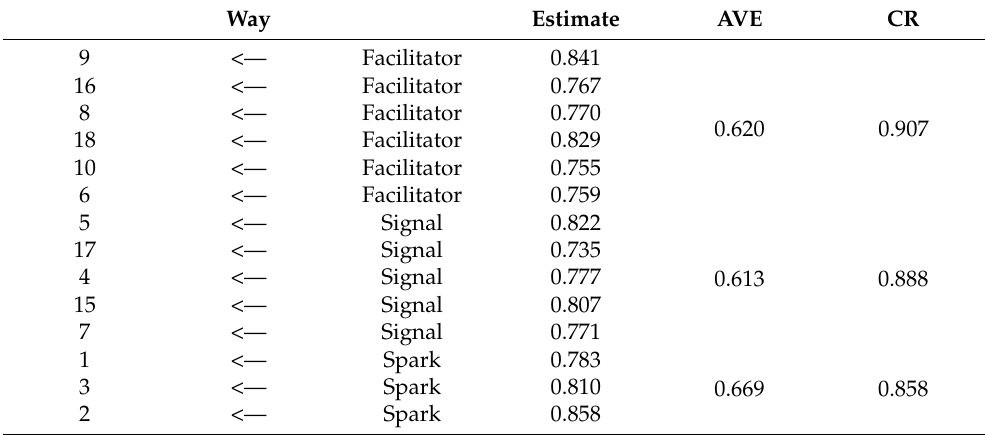
Table 10. Consolidation Validity Index.